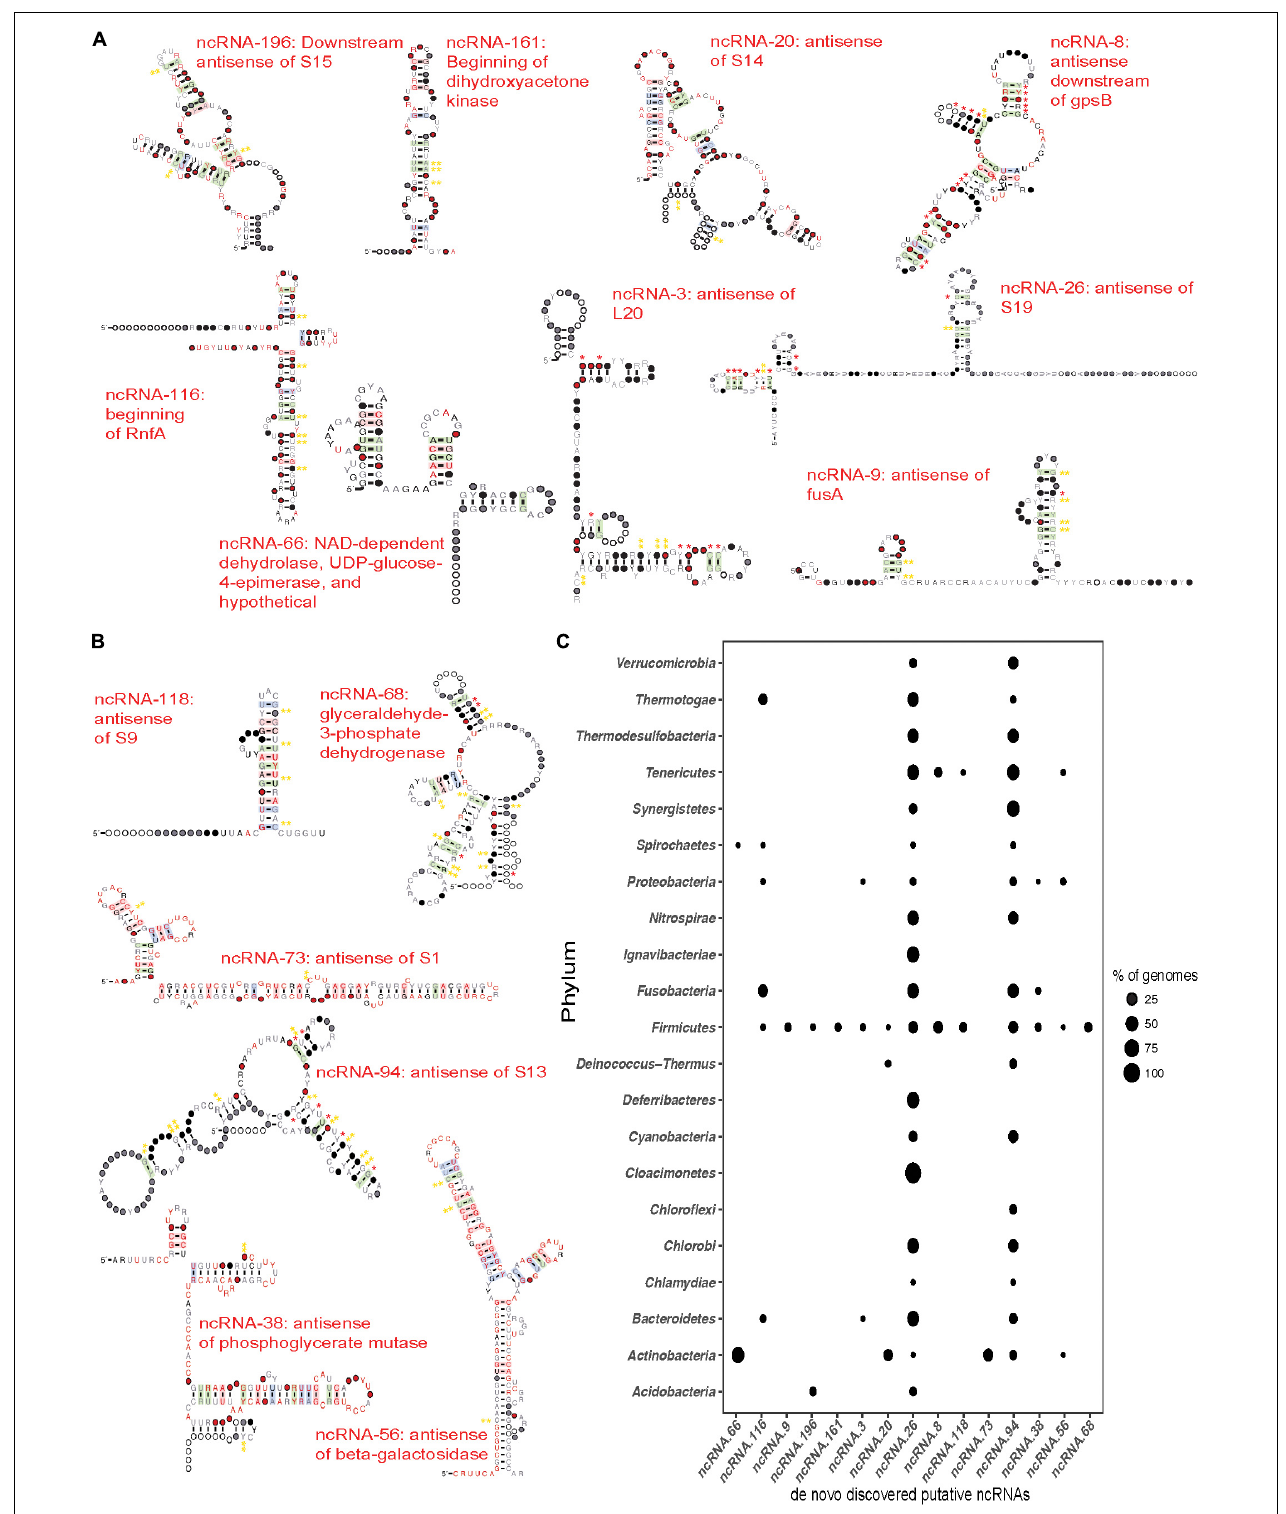
FIGURE 7 | de novo discovered ncRNAs in differentially expressed transcripts. Transcripts that showed no known ncRNAs were subjected to de novo RNA structure discovery using Graphclust (Heyne et al., 2012). Potential ncRNAs were manually curated and a subset of ncRNA were chosen based on predicted secondary